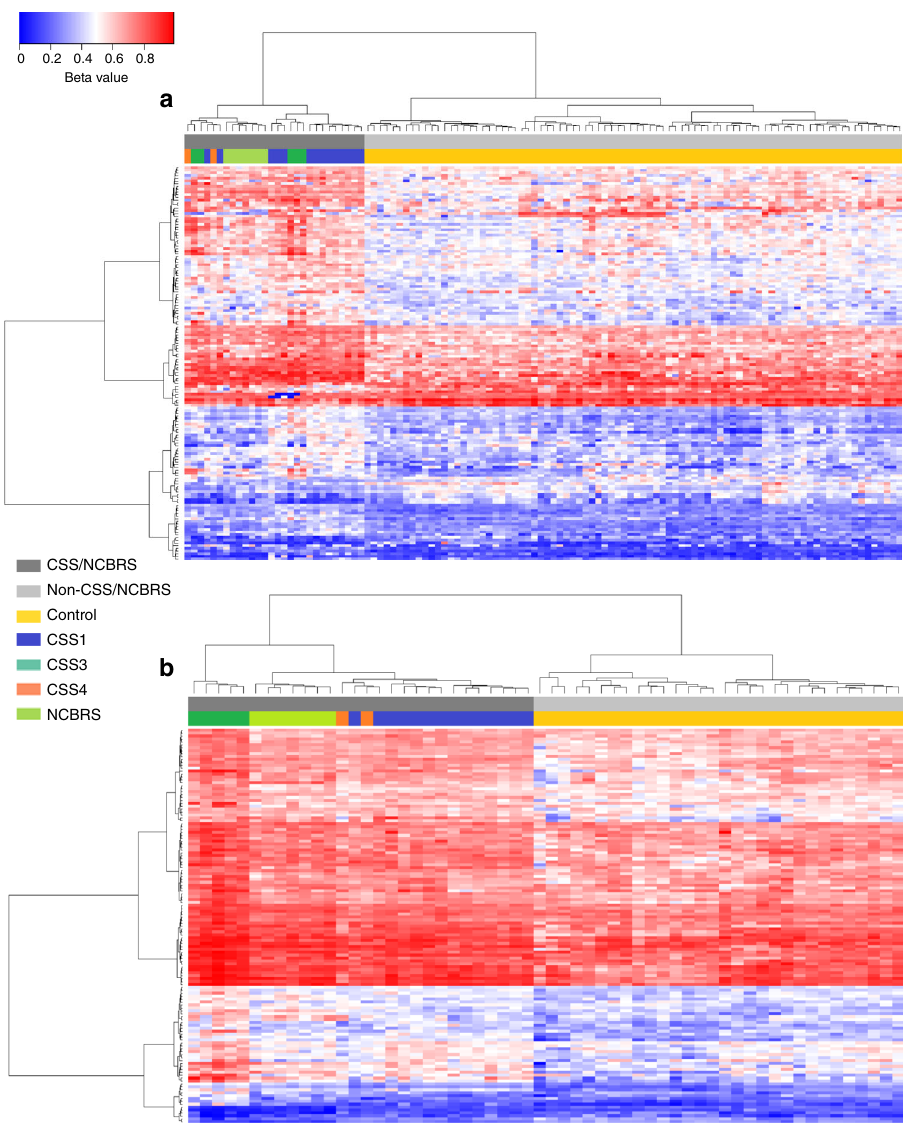
Fig. 1 Clustering analysis using the probe-sets identi fi ed in CSS1 and CSS3. Clustering analysis was performed using Ward ’ s method on Euclidian distance. Rows represent the CpG probes, and columns represent the subjects. The color scale from dark blue to dark red represents the range of the methylation levels (beta values) between 0 and 1. The top pane represents the overall status of the condition, i.e., CSS/NCBRS vs. non-CSS/NCBRS. The lower pane indicates the subtype for every sample including CSS1 (dark blue), CSS3 (dark green), CSS4 (orange), NCBRS (light green), and controls (yellow). a Hierarchical clustering of 146 probes differentially methylated between patients with CSS1 and controls generates two clusters: one composed of all CSS and NCBRS patients (CSS1, CSS3, CSS4, and NCBRS), and the other composed of controls and other non-CSS/NCBRS samples. b A similar pattern is observed using the 135 probes that were speci fi cally identi fi ed for the CSS3 samples; however, patients other than CSS3 (CSS1, CSS4, and NCBRS) show